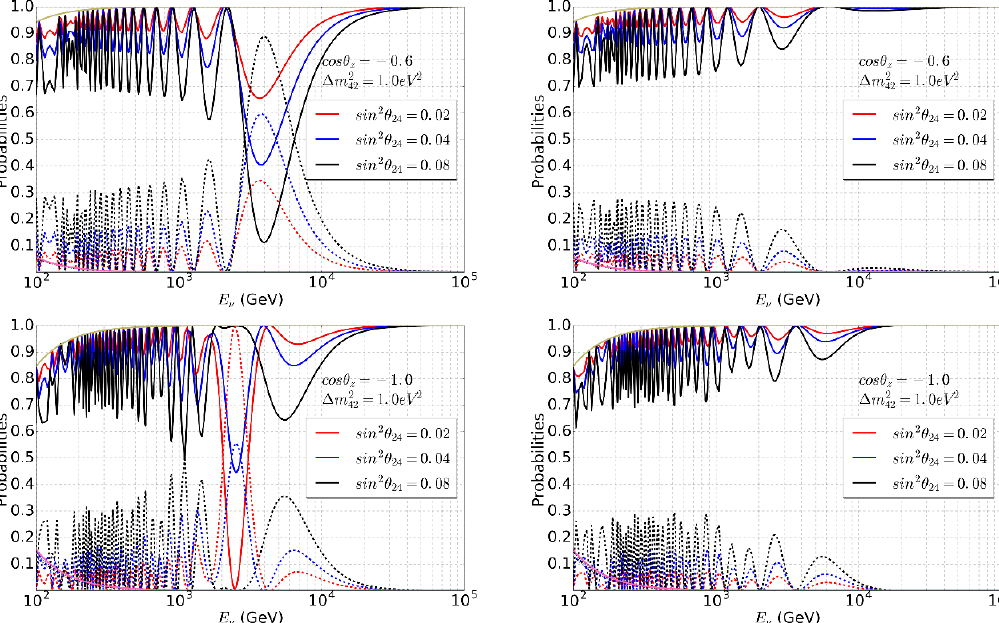
Figure 2 . Same as (cid:12)gure 1 but for (cid:13)avor mixing scheme